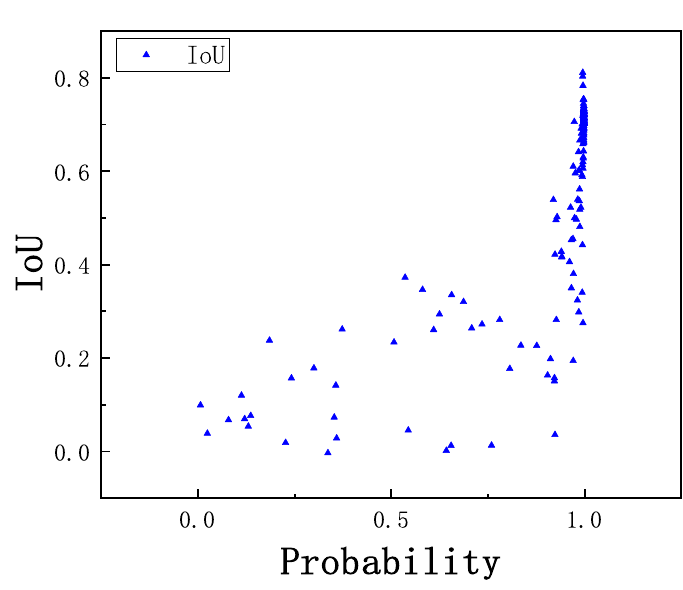
Figure 12. Data distribution of classification accuracy and IoU.